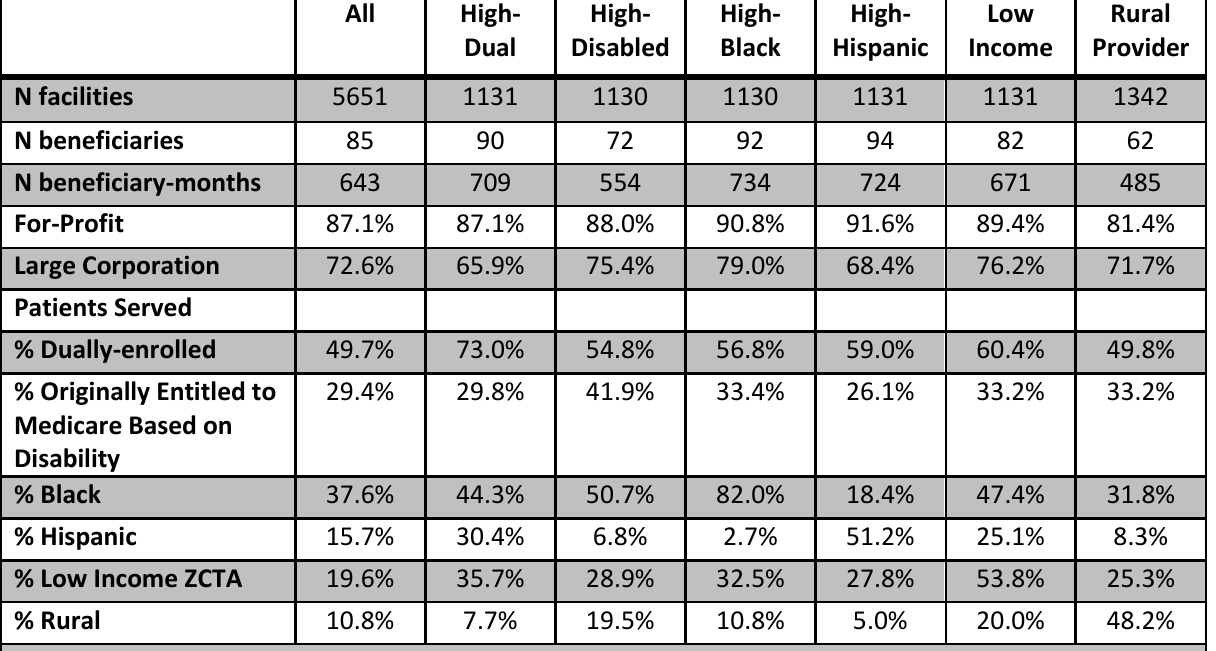
Table 11.2: Facility Characteristics